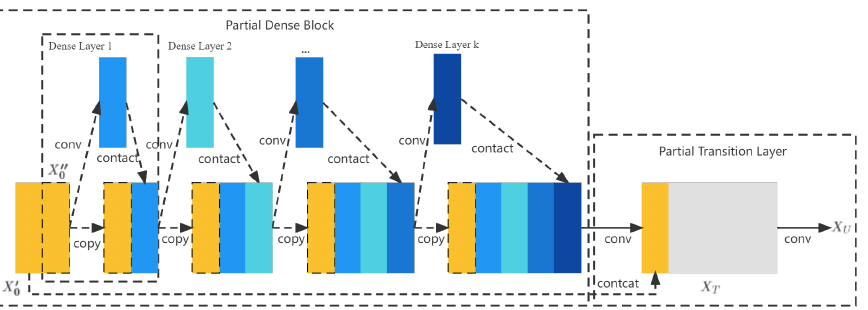
Figure 6. The structure of CSPDarknet53, in which different color blocks represent different functional layers; orange represents the input layer, blue represents the convolution layer, and the darker color represents the higher convolution